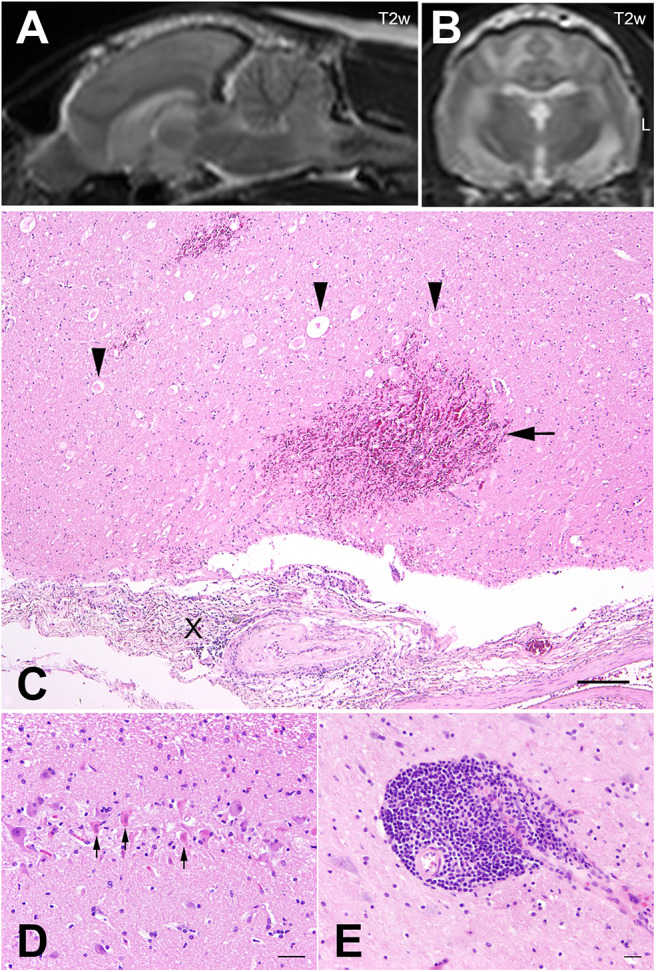
Cat no. 2. (A,B) Magnetic resonance imaging (MRI): Midsagittal (A) and transversal section (B) of the brain of cat 2 at the level of the interthalamic adhesion in T2 weighted (T2w) sequences. Note the intramedullary hyperintense lesions of the brainstem and the subcortical white matter as well as the mass lesion with signal void in the myelencephalon. Left side is marked with L. (C–E) Histopathology. (C) Pons, focally severe meningitis (X) with severe hemorrhages in the adjacent neuroparenchyma (arrow) and vacuolization of the white matter as well as spheroids (arrowheads), HE, bar = 100 μm. (D) Hippocampus, severe neuronal necrosis (arrows) and loss. HE, bar = 50 μm. (E) Cerebral cortex with focally severe, perivascular, lympho-histiocytic encephalitis. HE, bar = 60 μm.